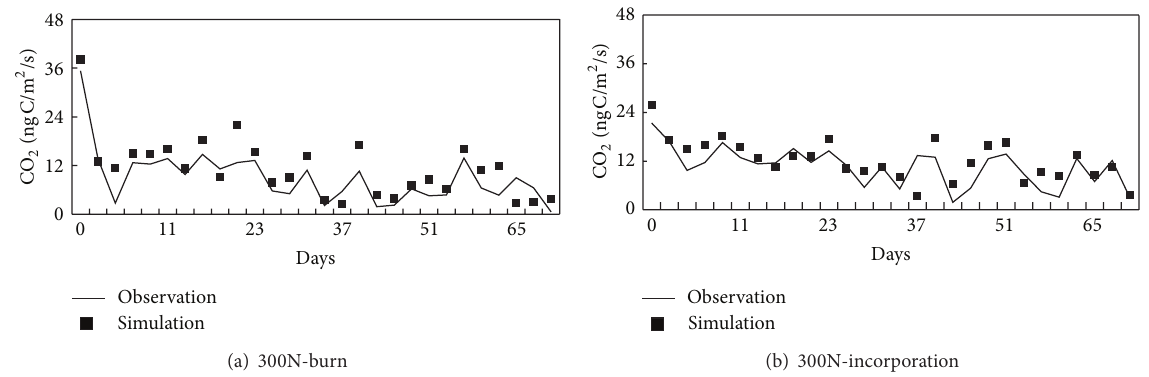
Figure 1: Comparison of observed and simulated CO 2 flux during straw retention period.